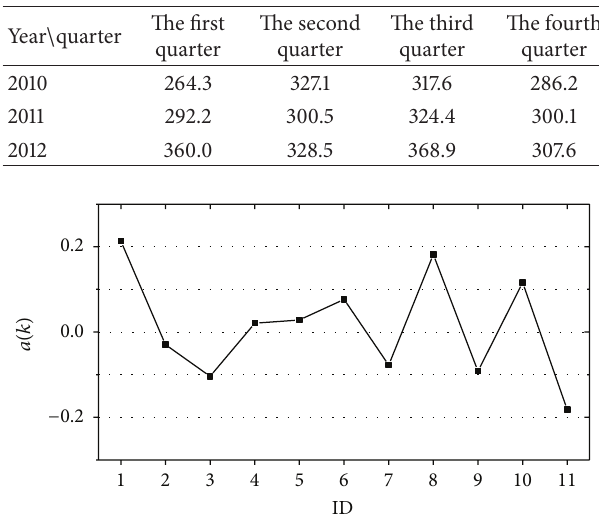
Figure 1: Line graph of the annulus development